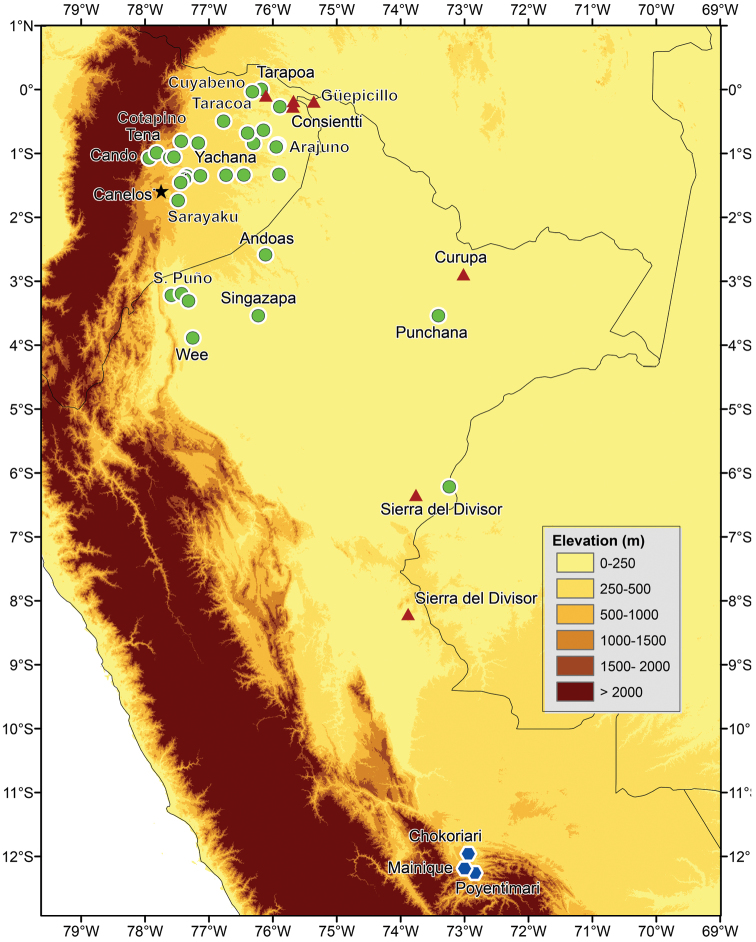
Records of Osteocephalus buckleyi, Osteocephalus cabrerai,and Osteocephalus germani. Osteocephalus buckleyi, circles; Osteocephalus cabrerai, triangles, and Osteocephalus germani, hexagons. The type locality of Osteocephalus buckleyi is shown with a star. Locality data from the literature (Duellman and Mendelson 1995; Jungfer 2010; Peracca 1904; Ron et al. 2010) and specimens deposited at Museo de Zoología of Pontificia Universidad Católica del Ecuador, the Herpetology Collection, Escuela Politécnica Nacional, and Centro de Ornitología y Biodiversidad CORBIDI.